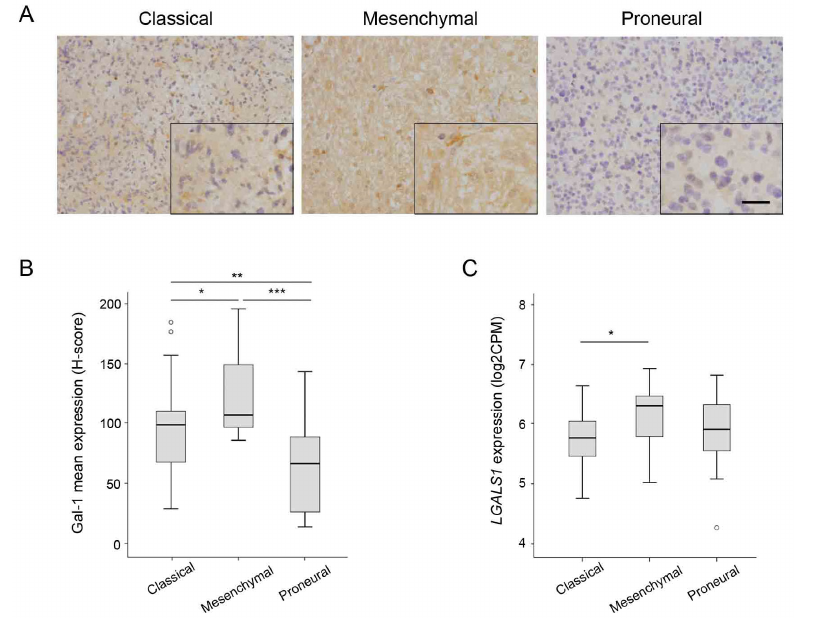
Figure 4. Gal-1 expression in glioblastoma molecular subtypes. ( A ) Representative images of Gal-1 immunostainings in classical, mesenchymal, and proneural glioblastoma tumors. Scale bars are 50 µ m (low magnification) or 25 µ m (high magnification inserts). ( B ) H-score quantification of Gal-1 protein expression depending on the molecular subtype. ( C ) LGALS1 RNA expression (log2CPM) according to the molecular subtype. * p < 0.05; ** p < 0.01; *** p < 0.001 (Mann ‐ Whitney U test).